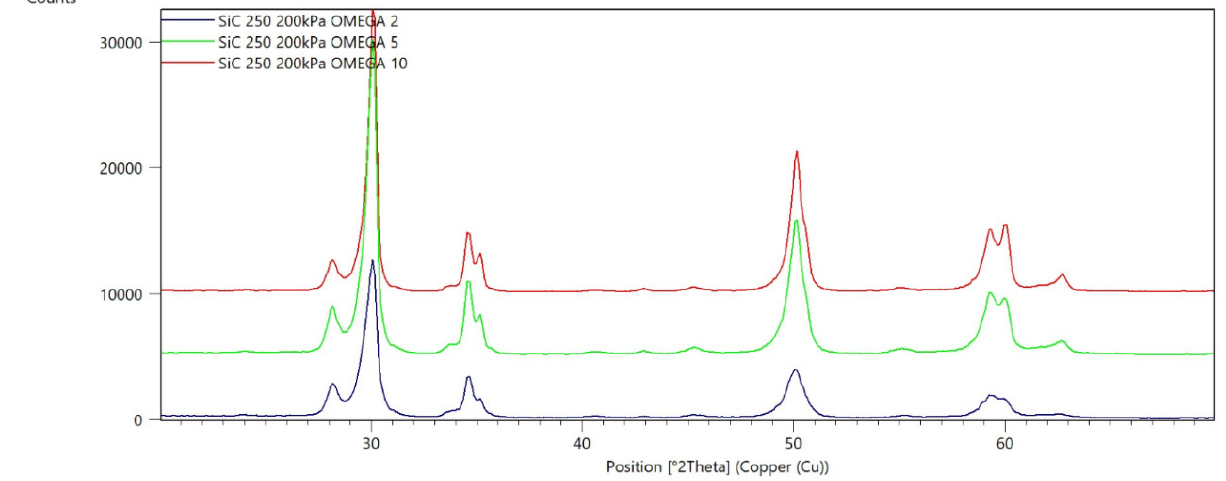
Figure 12. Diffraction patterns of sample K (abrasive—SiC 250 μ m, pressure 200 kPa).